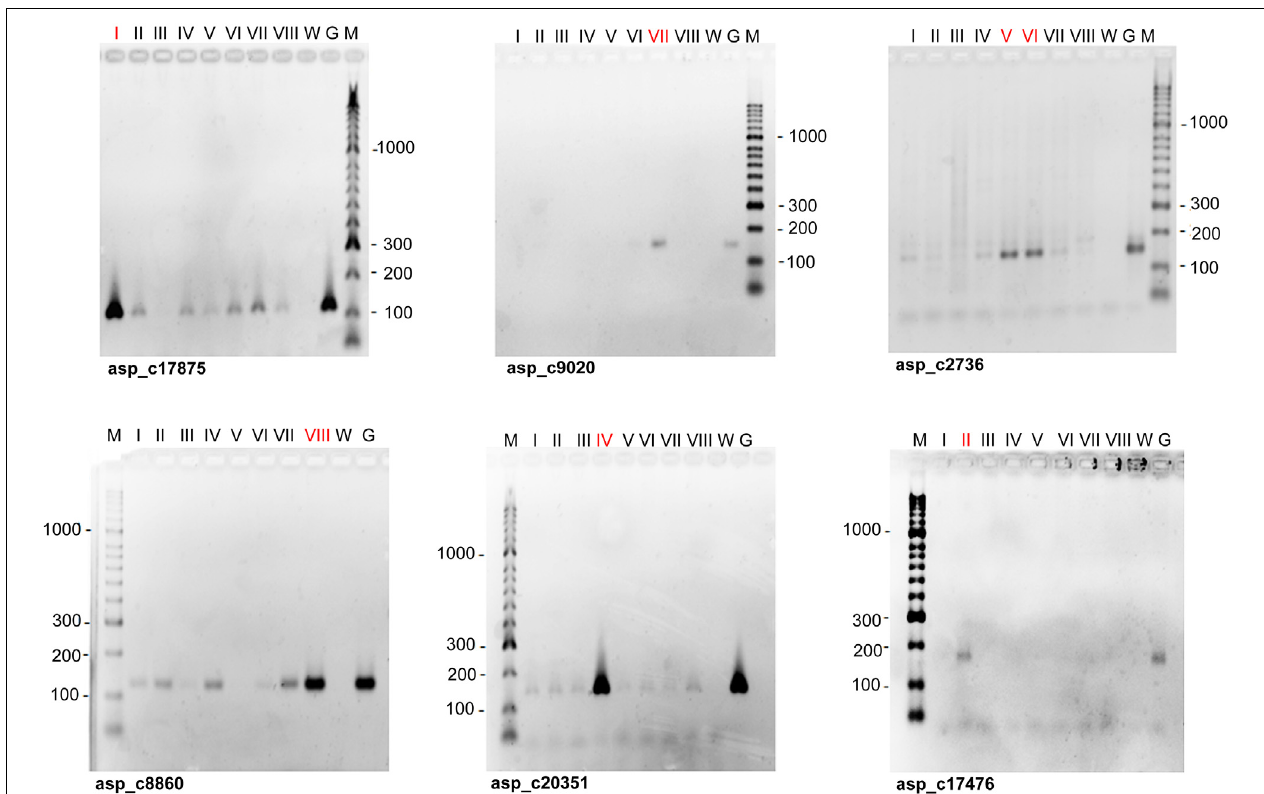
FIGURE 2 | Examples of the assignment of SSR markers to chromosomes of garden asparagus. Agarose gel electrophoresis was done with PCR products obtained with primers for SSR markers (asp_c) and DNA of chromosomes flow sorted from eight major peaks on the flow karyotype ( Figure 1A ) as templates (lanes I – VIII). The list of markers is given in Supplementary Table S1. The numbers of positive peaks are printed in red. Genomic DNA (lanes G) and distilled water (lanes W) were used as positive and negative controls, respectively. Lanes M: DNA ladder HyperLadder TM 50 bp (Bioline, London, United